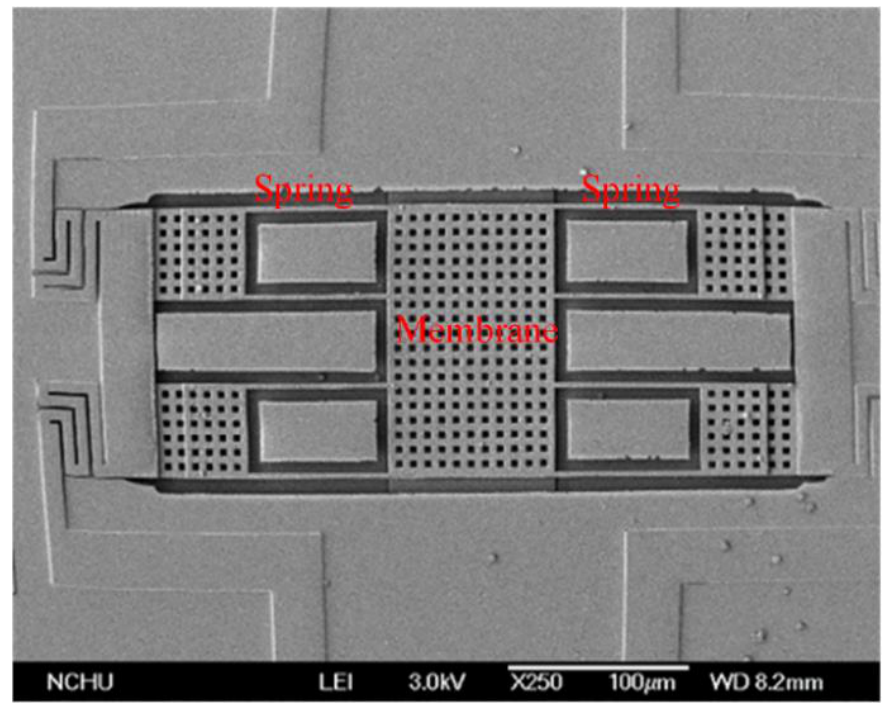
Figure 10. Scanning electron microscope (SEM) picture for the MSS.